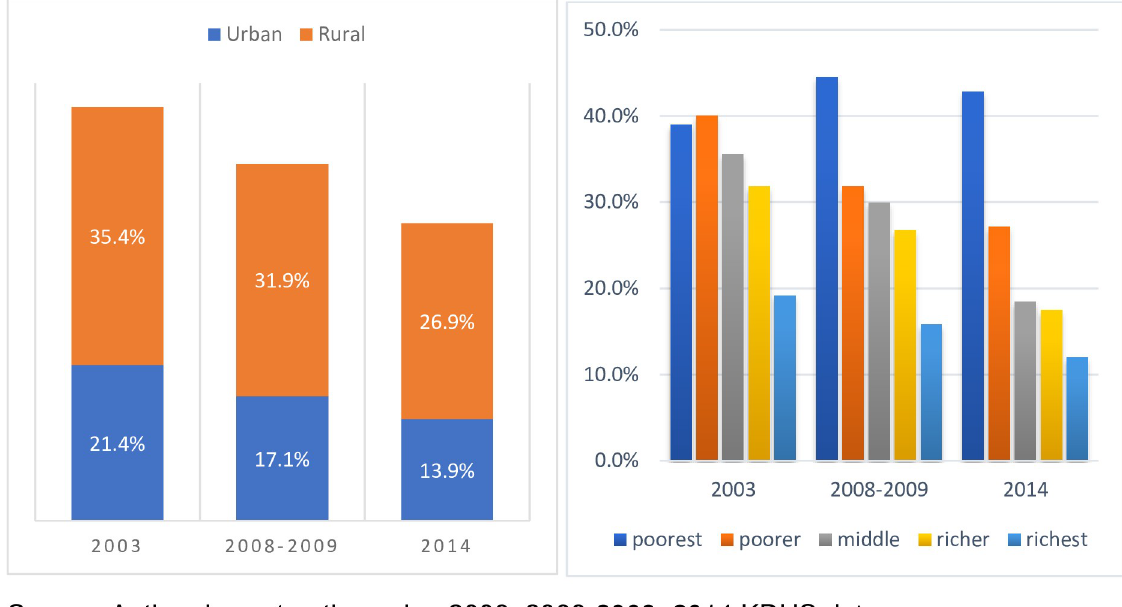
Fig 3. FGM/C prevalence across age cohorts and ethnicity. Shows FGM/C prevalence constructed using 2003, 2008–2009 and 2014 KDHS data. a) shows FGM/C prevalence by age cohorts across the three panels of KDHS data. b) shows FGM/C prevalence by ethnic groups across the three panels of KDHS